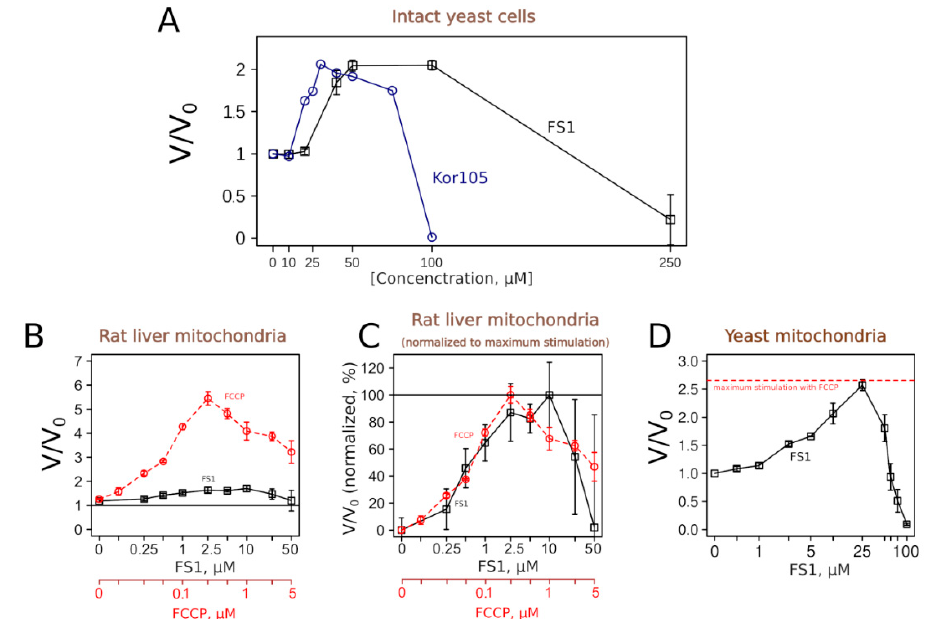
Figure 6. FS1 and Kor105 possess uncoupling activity. Respiration rates of intact yeast cells ( A ) and isolated yeast mitochondria ( D ) in the presence of different concentrations of the compounds, expressed as V divided by V0 (V, the rate in the presence of a compound, divided by V0, the rate without addition). ( B , C ) Stimulation of the respiration of rat liver mitochondria by FS1 and FCCP, absolute values of V divided by V0 and normalized ones (the maximal stimulation by a compound corresponds to 100%; the value without addition, i.e., without stimulation, corresponds to 0%), respectively. Error bars correspond to standard deviations; n = 3.